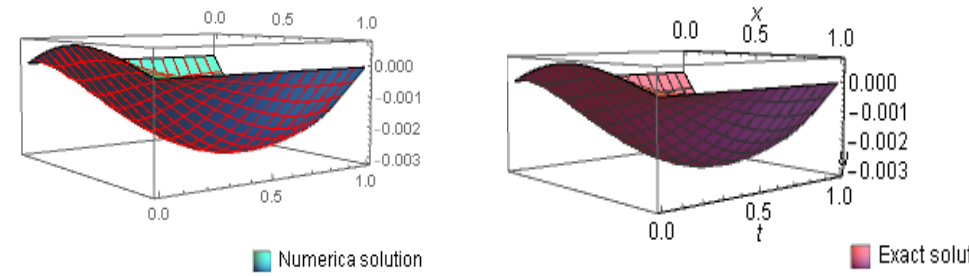
Figure 2. The exact and numerical solution at c 1 = 0.5, c 0 = − 1.8 when α = 1.5 and β = 1.47.